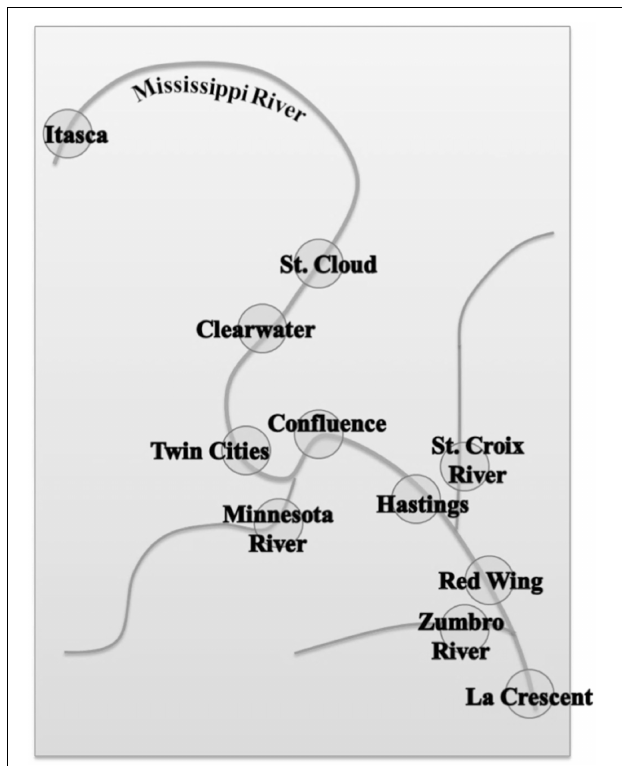
FIGURE 1 | Relative location of sampling sites along the Mississippi River and major contributing